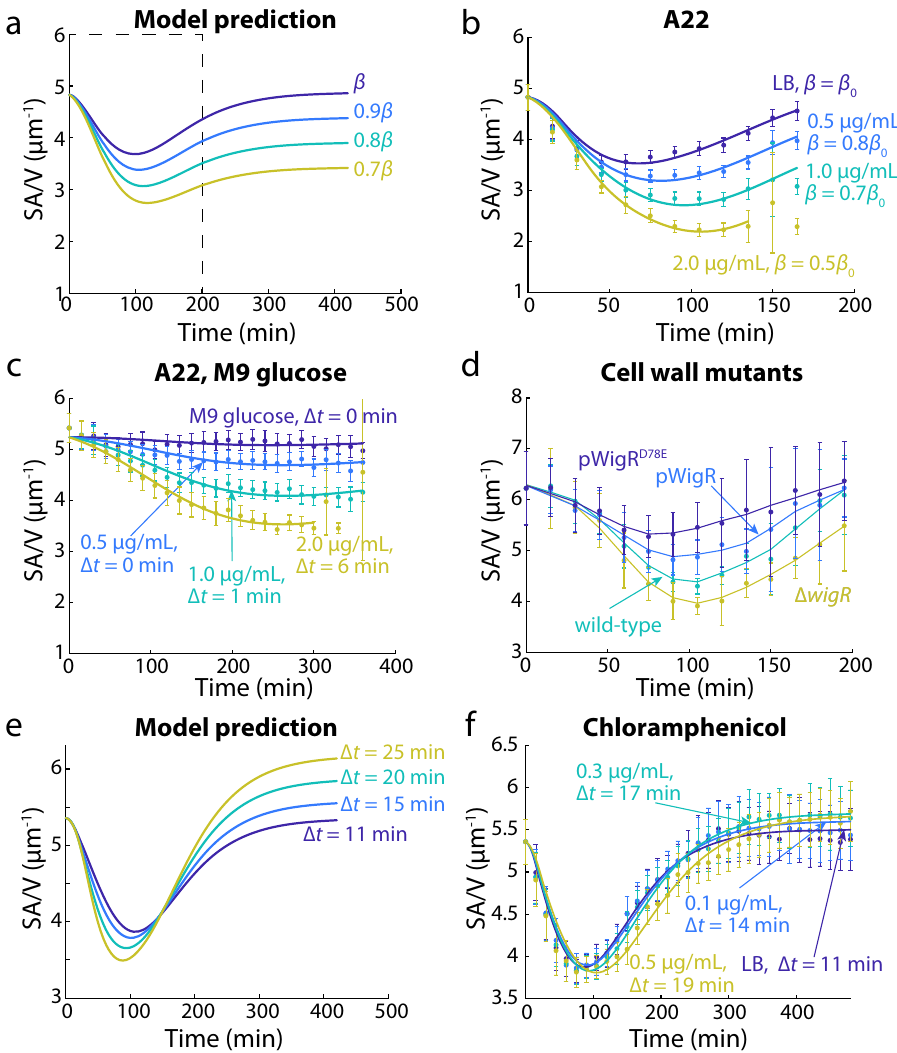
Fig. 6 Time-delay model quantitatively predicts SA/V changes due to inhibiting cell-wall synthesis or protein translation. a The model predicts that decreasing β results in decreased SA/V over time. Dashed box highlights the time scale tested in experiment. b Shape growth curves during A22 treatment in LB exhibited similar SA/V dynamics as predicted in a . c Shape growth curves with A22 treatment in M9 glucose also exhibited decreases in SA/V, even though SA/V remained largely constant without A22. Higher A22 concentrations also led to non-zero Δ t , indicating that cells must adjust their proteome under inhibition of cell-wall synthesis. d Shape growth curves for V. cholerae cell-wall synthesis mutants. Overexpression of WigR (pWigR, pWigR D78E